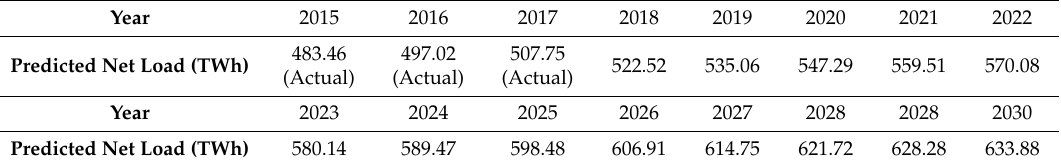
Table 10. The predicted net load from 2018 to 2030.